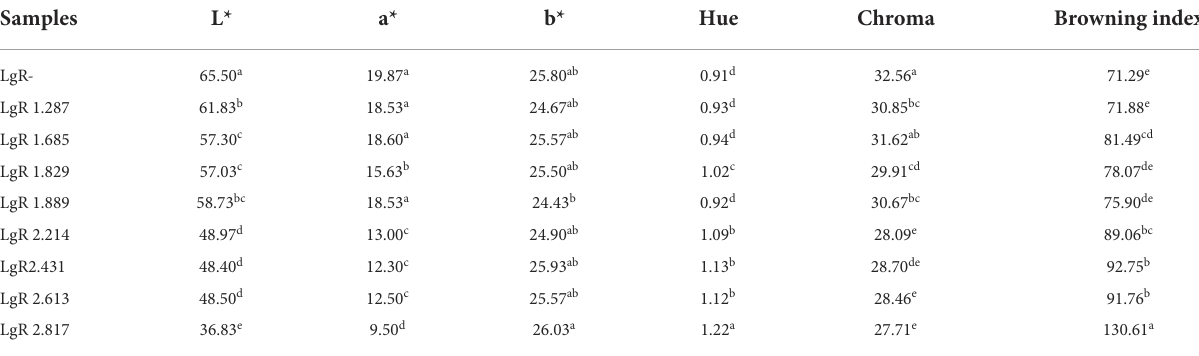
TABLE 2 Color measurements of soybean meal powder. Samples